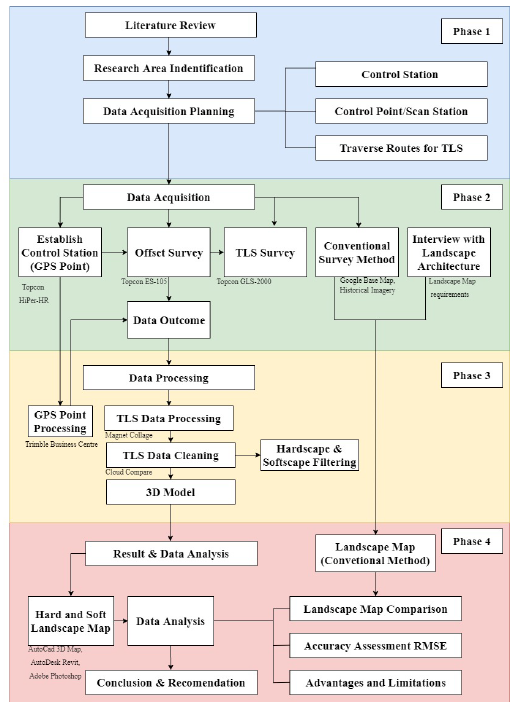
Figure 2.1 Methodology flowchart in this study